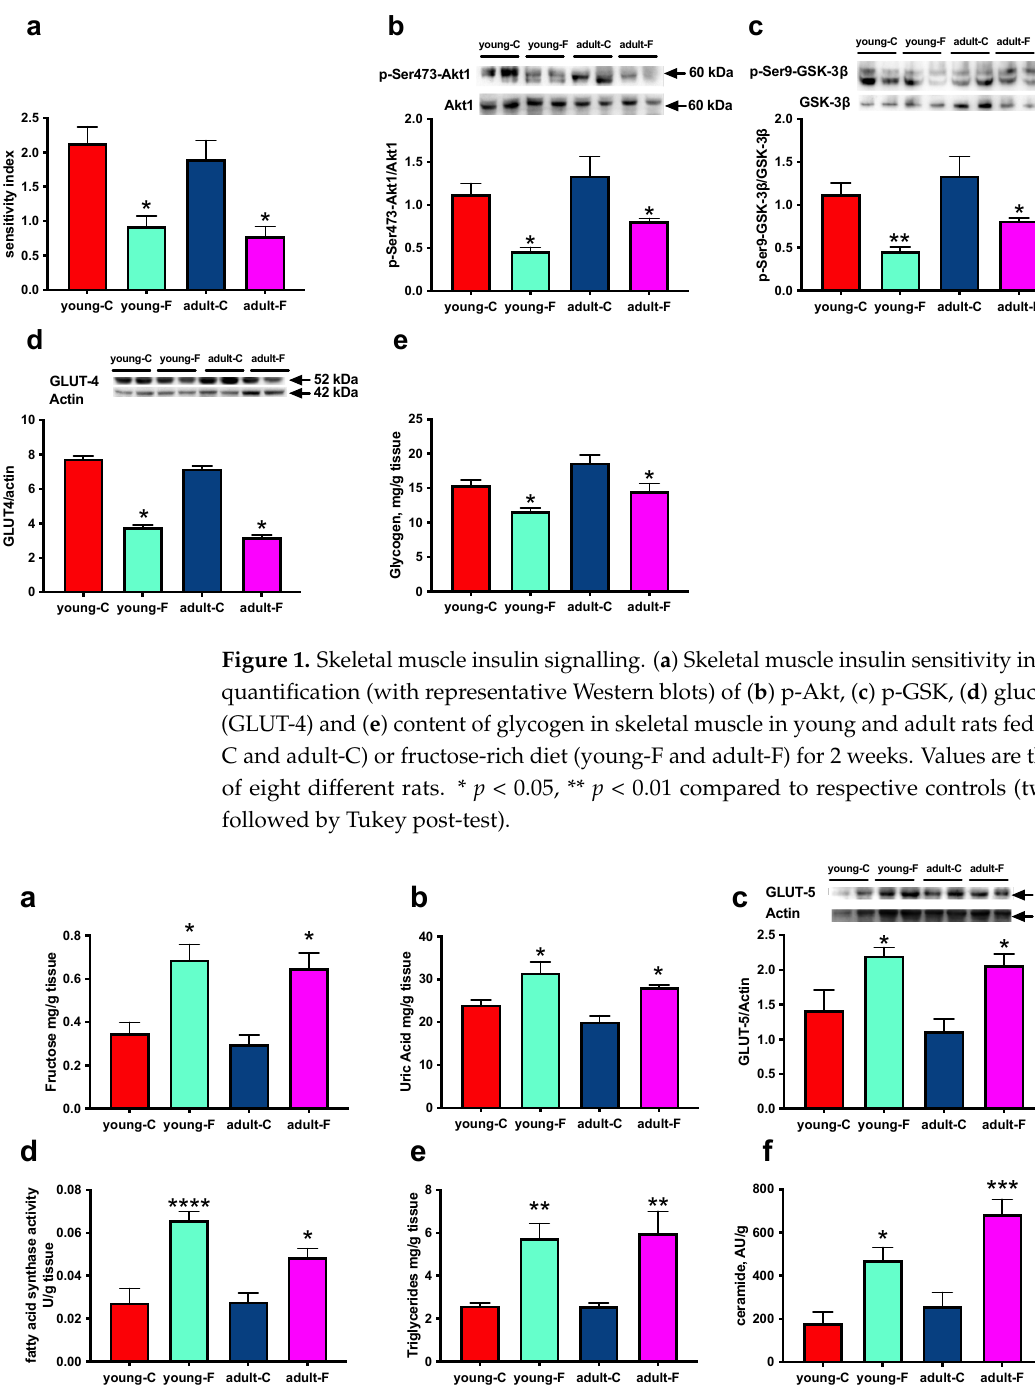
Figure 2. Composition of skeletal muscle ( a ) Content of fructose, ( b ) uric acid, ( c ) glucose transporter 5 (GLUT-5), ( d ) fatty acid synthase (FAS) activity, ( e ) triglycerides and ( f ) ceramide in skeletal muscles of young and adult rats fed a control (young-C and adult-C) or fructose-rich diet (young-F and adult-F) for 2 weeks. Values are the means ± SEM of eight different rats. * p < 0.05, ** p < 0.01, *** p < 0.001, **** p < 0.0001 compared to respective controls (two-way ANOVA followed by Tukey